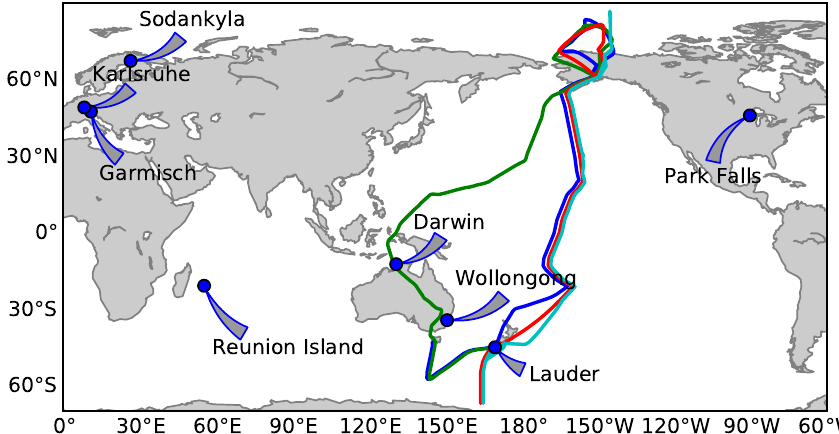
Figure 4. Location of a few TCCON stations used in this paper (blue points) and trajectories of the 2011 HIPPO campaigns. The campaign periods are respectively 16–29 June (blue), 28 June–11 July (green), 19–30 August (red), and 29 August–9 September (cyan). Note that for the plot, some trajectories are shifted one or two degrees east or west in order to avoid superposition between them.